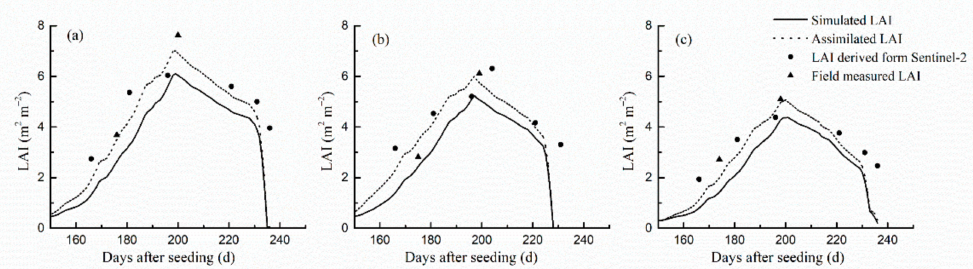
Figure 4. Simulated leaf area index (LAI), assimilated LAI, LAI derived from Sentinel-2, and field-measured LAI for winter wheat in the three sites in 2019. ( a ) Nanxindian village of Xiangfen county; ( b ) Zezhang village of Xinjiang county; ( c ) Su village of Wenxi county in